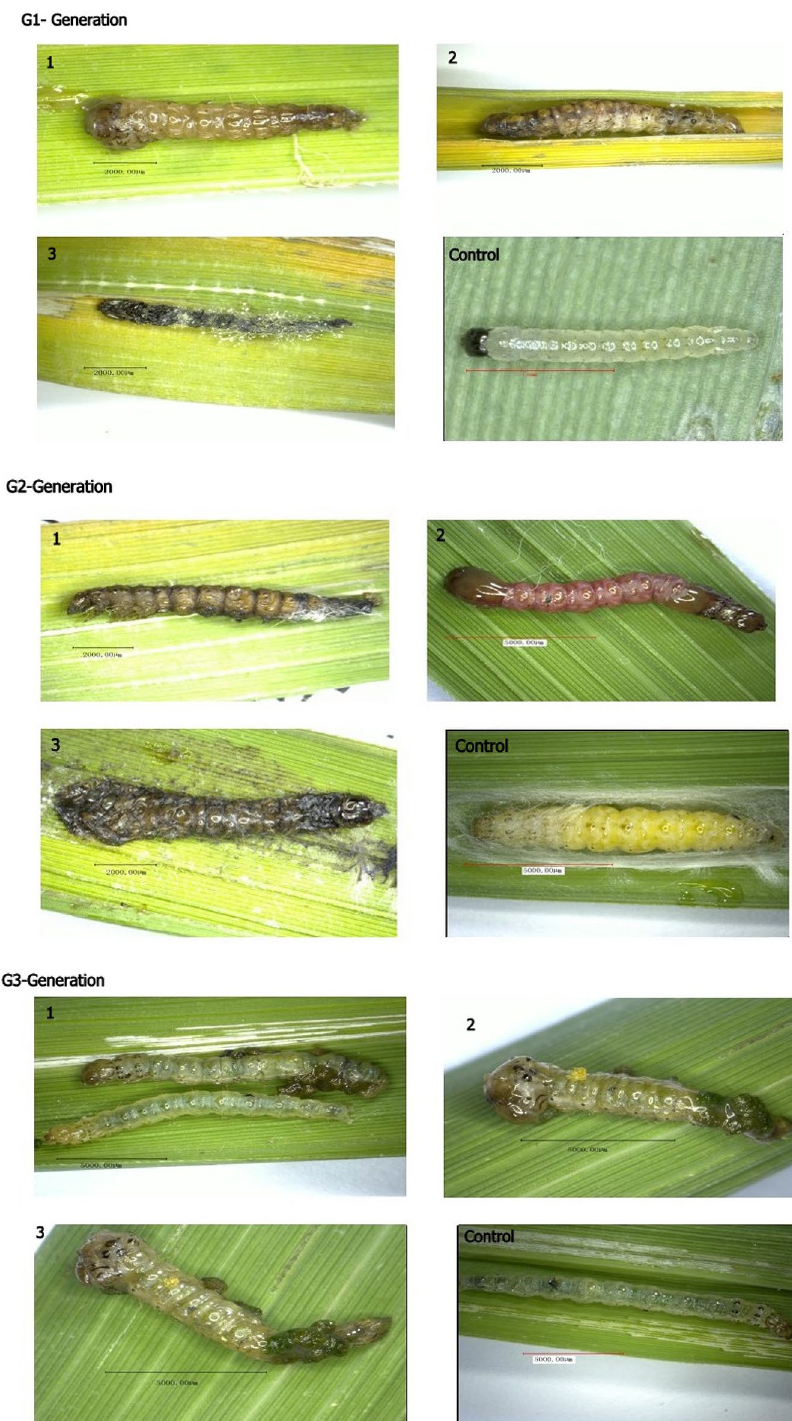
Figure 7. The phenotypic deformities were evaluated from larvae and pupae in G1–G3 generations . Infected larvae were observed in G1–G3 generations of treated insects using